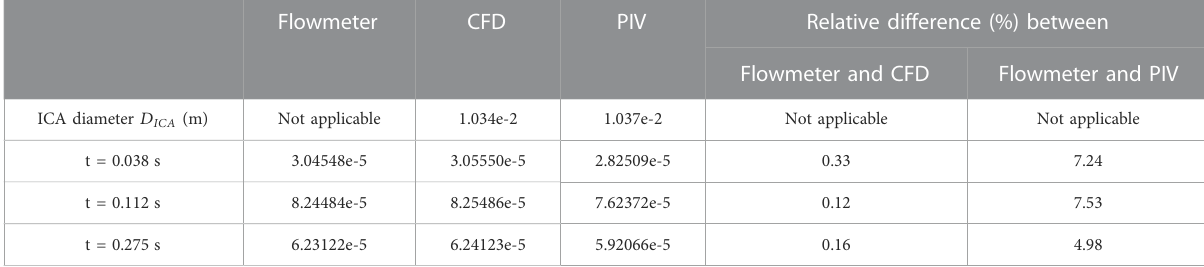
TABLE 1 Volumetric fl owrate V (m 3 /s) comparisons among fl owmeter, CFD and PIV under selected time instants.